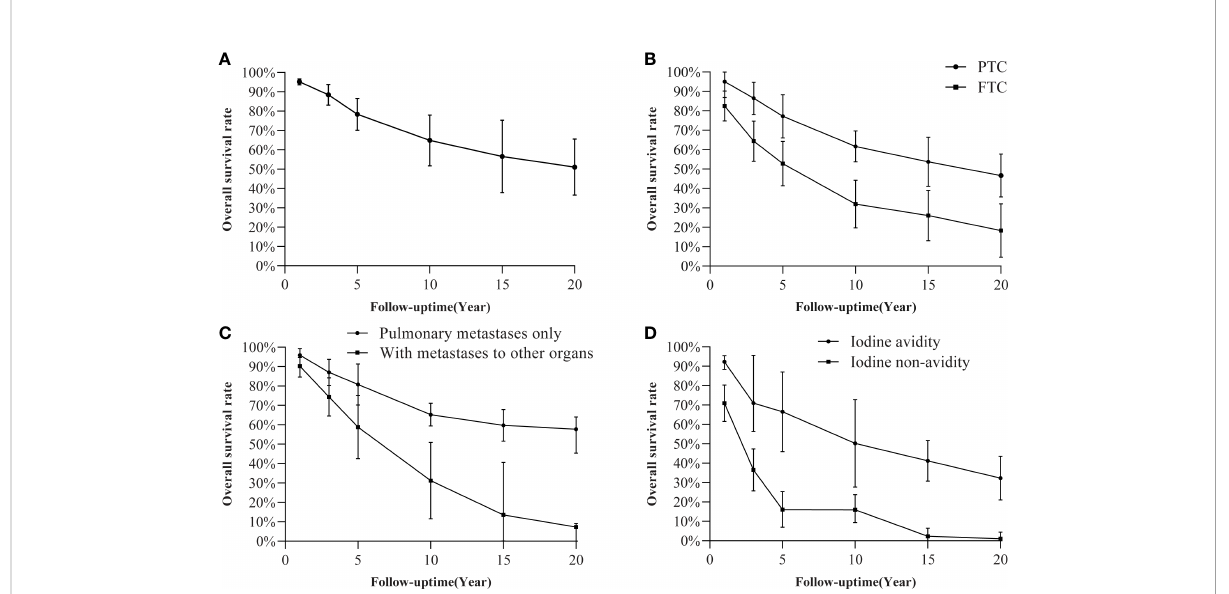
FIGURE 3 Pooled OS rate point estimates: (A) all included patients; (B) PTC versus FTC; (C) pulmonary metastases only versus with metastases to other organs; (D) iodine avidity versus iodine